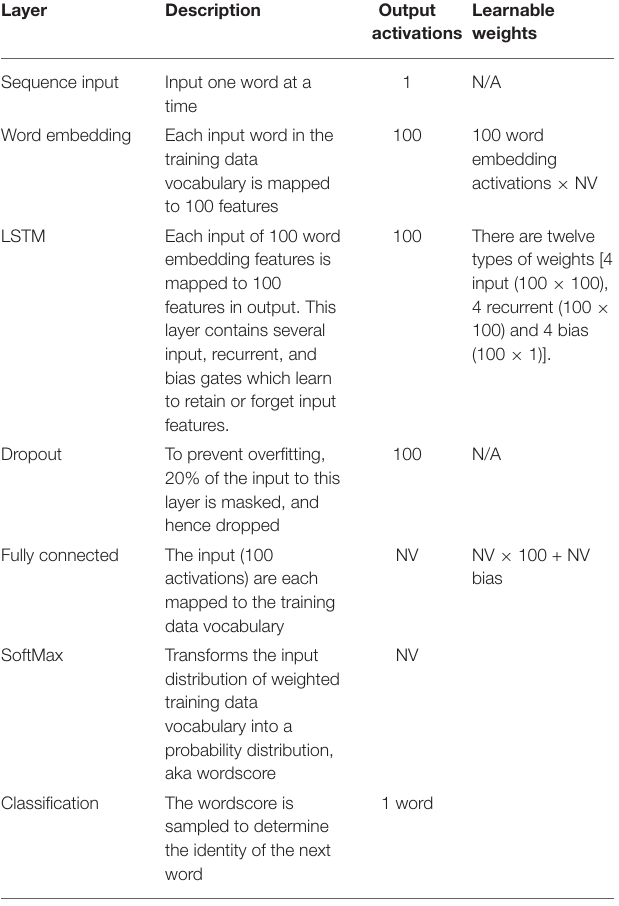
TABLE 2 | Layers of the model employed